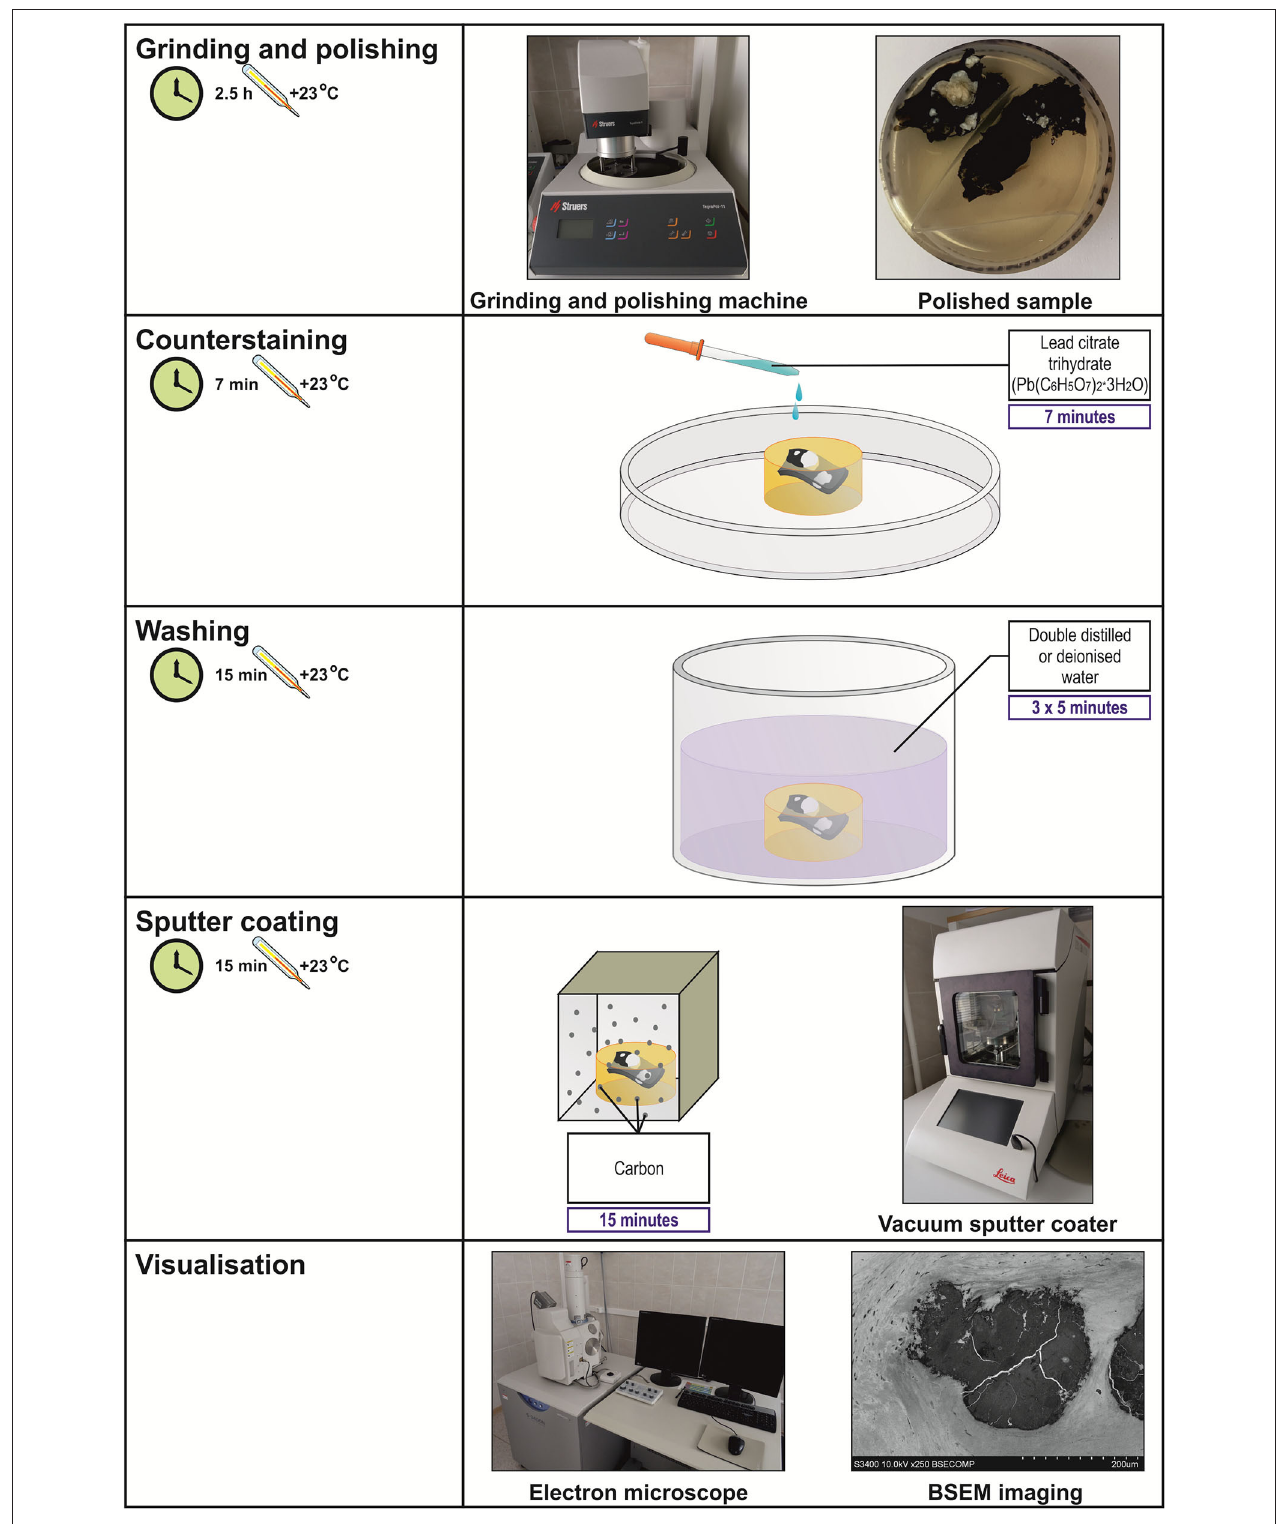
FIGURE 3 | Workflow diagram for EM-BSEM from grinding and polishing to visualisation.